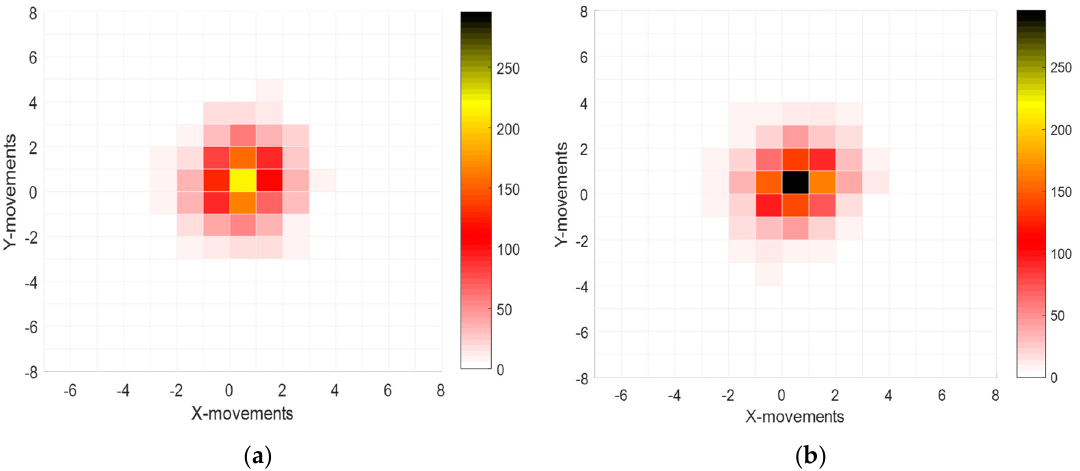
Figure 10. 2D histogram of temporal fluctuations measured at z 3 plane: ( a ) Pattern Test. ( b ) Test #2. Source: Authors.